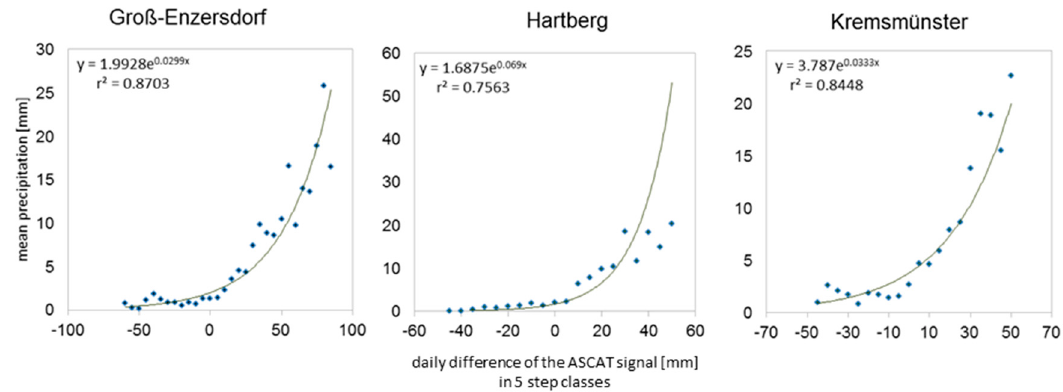
Figure 2. Scatterplot of daily difference of the Advanced SCATterometer (ASCAT) signal (in 5 step classes in mm) and the average precipitation [mm] as well as their exponential regression equation and r 2 —March–October